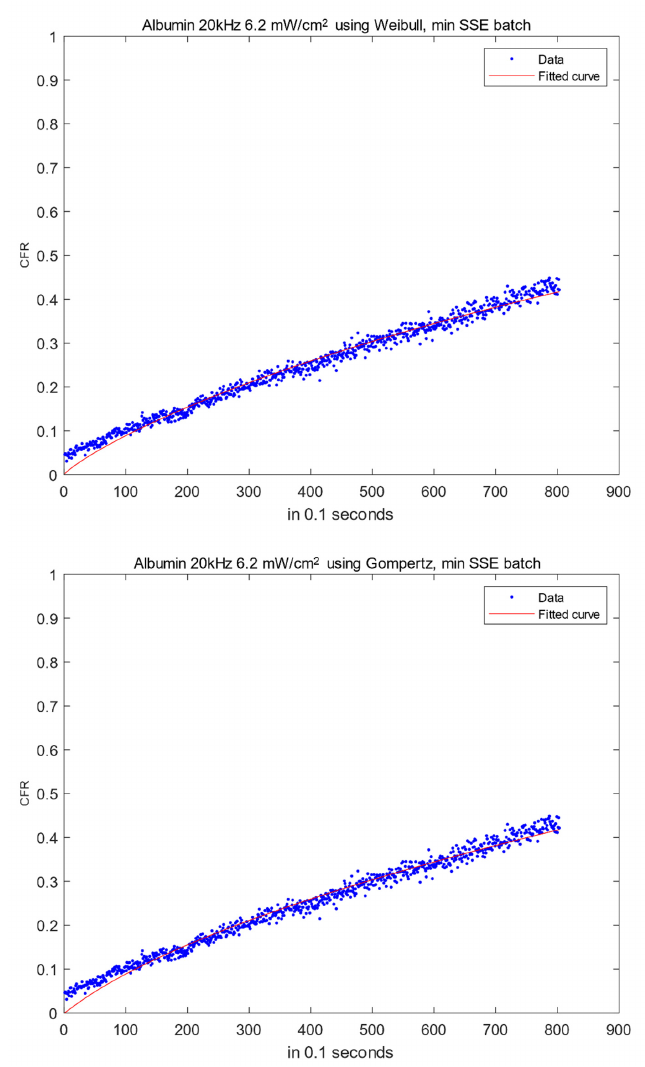
Figure 2. Selected model fittings for albumin at 20 kHz (6.2 mW/cm 2 ).